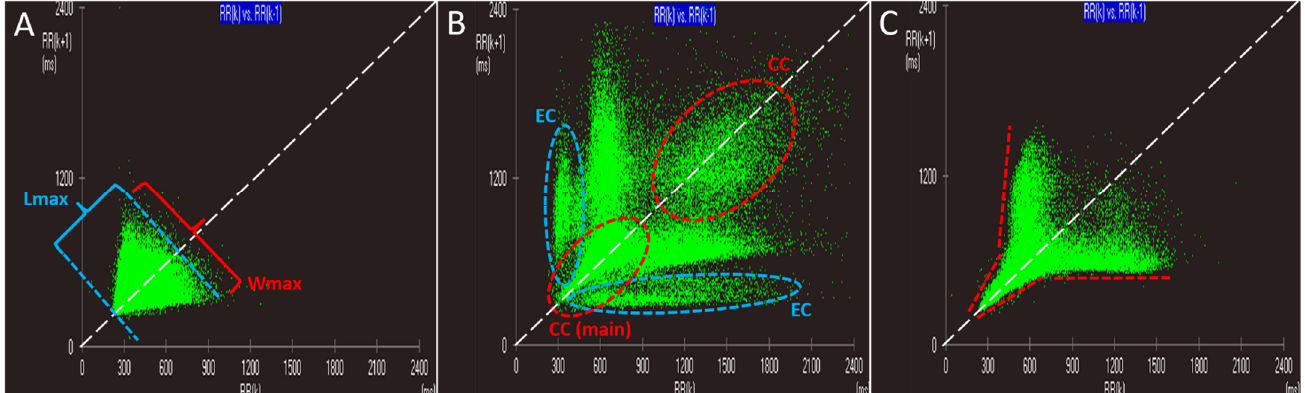
Figure 2. Graphic criteria used for classification of Lorenz plot patterns. ( A ): Example Lorenz plot generated from a Holter recording obtained from a dog with atrial fibrillation. Maximal length (Lmax) and maximal width (Wmax) of the cluster of dots are illustrated by blue and red lines, respectively. ( B ): Example Lorenz plot generated from a Holter recording obtained from a dog with sinus rhythm associated with a normal heart rate variability and frequent ventricular premature complexes. The central cluster (CC) and eccentric cluster (EC) are illustrated by red and blue dotted lines, respectively. Note that both CCs are located along the line of identity and that the main CC is placed at the lower left corner of the graph. Note also that both ECs arise from the lower left corner of the graph close to the body of the main CC and then extend outside the line of identity, one approximately parallel to the X-axis and the other approximately parallel to the Y-axis of the plot. ( C ): Example Lorenz plot from a Holter recording obtained from a dog with a diagnosis of sinus rhythm associated with a normal heart rate variability. Red dotted lines outline the margin of the CC and its diverging arms. Note that both arms are clearly attached to the CC, acting as its direct continuation and not as distinct ECs. Table 1. Quantitative and qualitative features of Lorenz plot patterns.